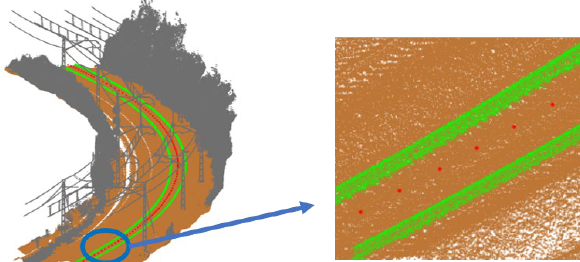
Figure 5. Semantic segmentation of a railway section. Rails (red), masts (blue), droppers (black), wiring (green) and signs (yellow) are detected in the 3D point